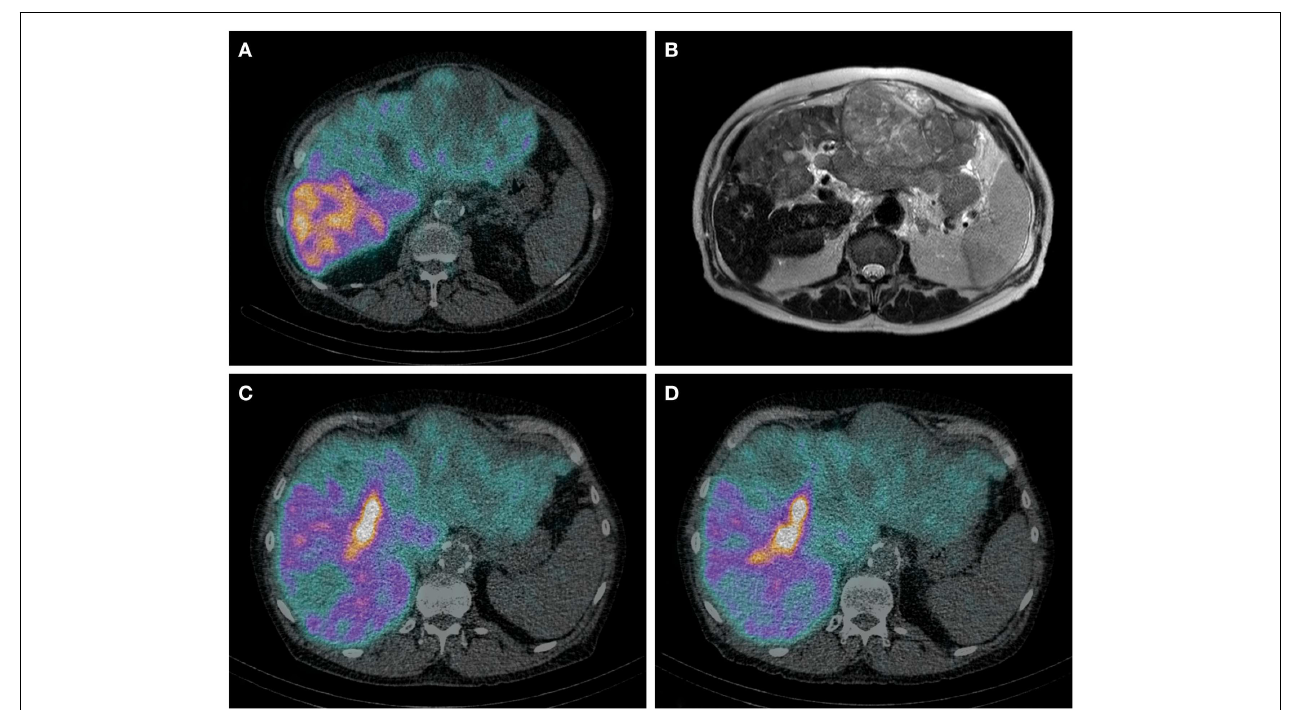
including segment 4. (C) It is from the same HBS SPECT/CT as image (A) , but shown in a different axial plane.The decrease of 99m Tc-mebrofenin uptake after treatment is best visible in segment 4.The area of high uptake is biliary excretion in a dilated bile